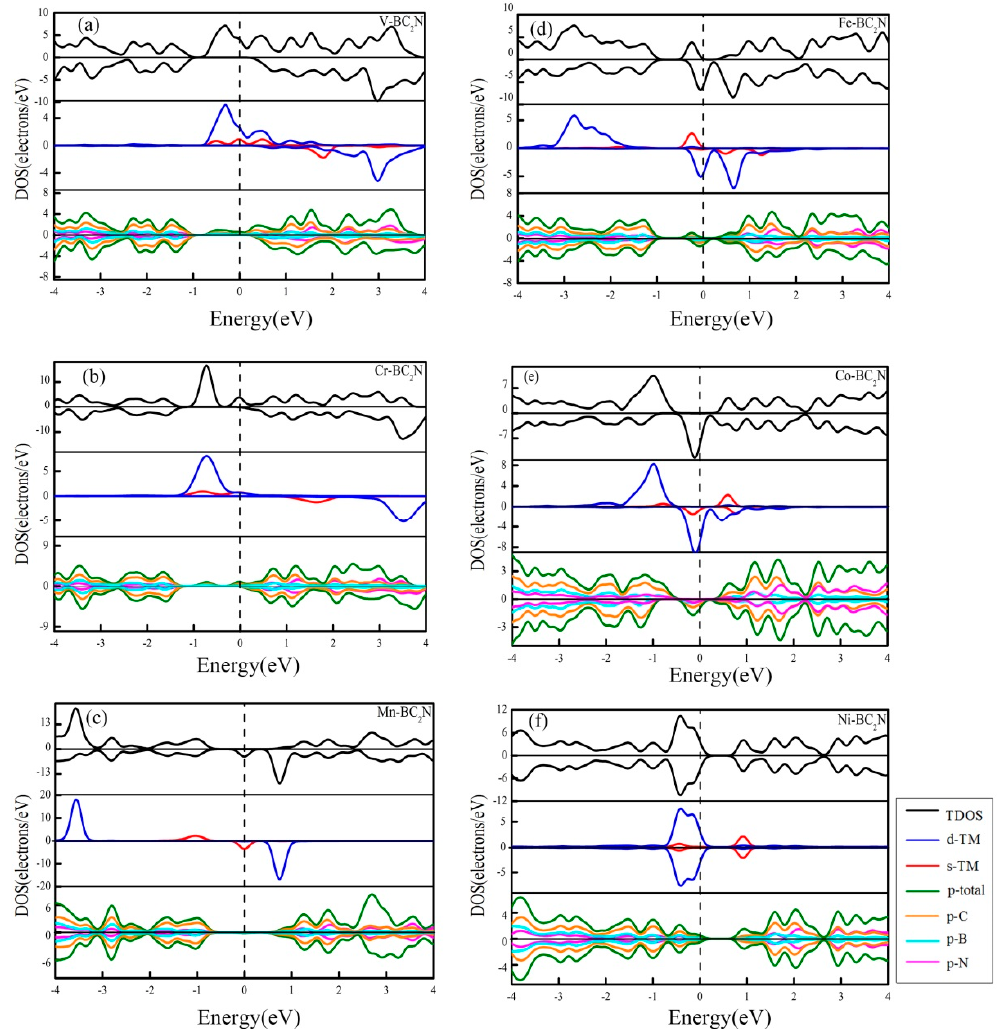
Figure 7. ( a )–( f ) The density of states for the monolayer BC 2 N doped by transition metal atoms. The upper, middle and lower sheets are the total density of states of all stable systems, the partial density of states of the 3d transition metal atoms and the partial density of states of the B, C and N atoms, respectively.